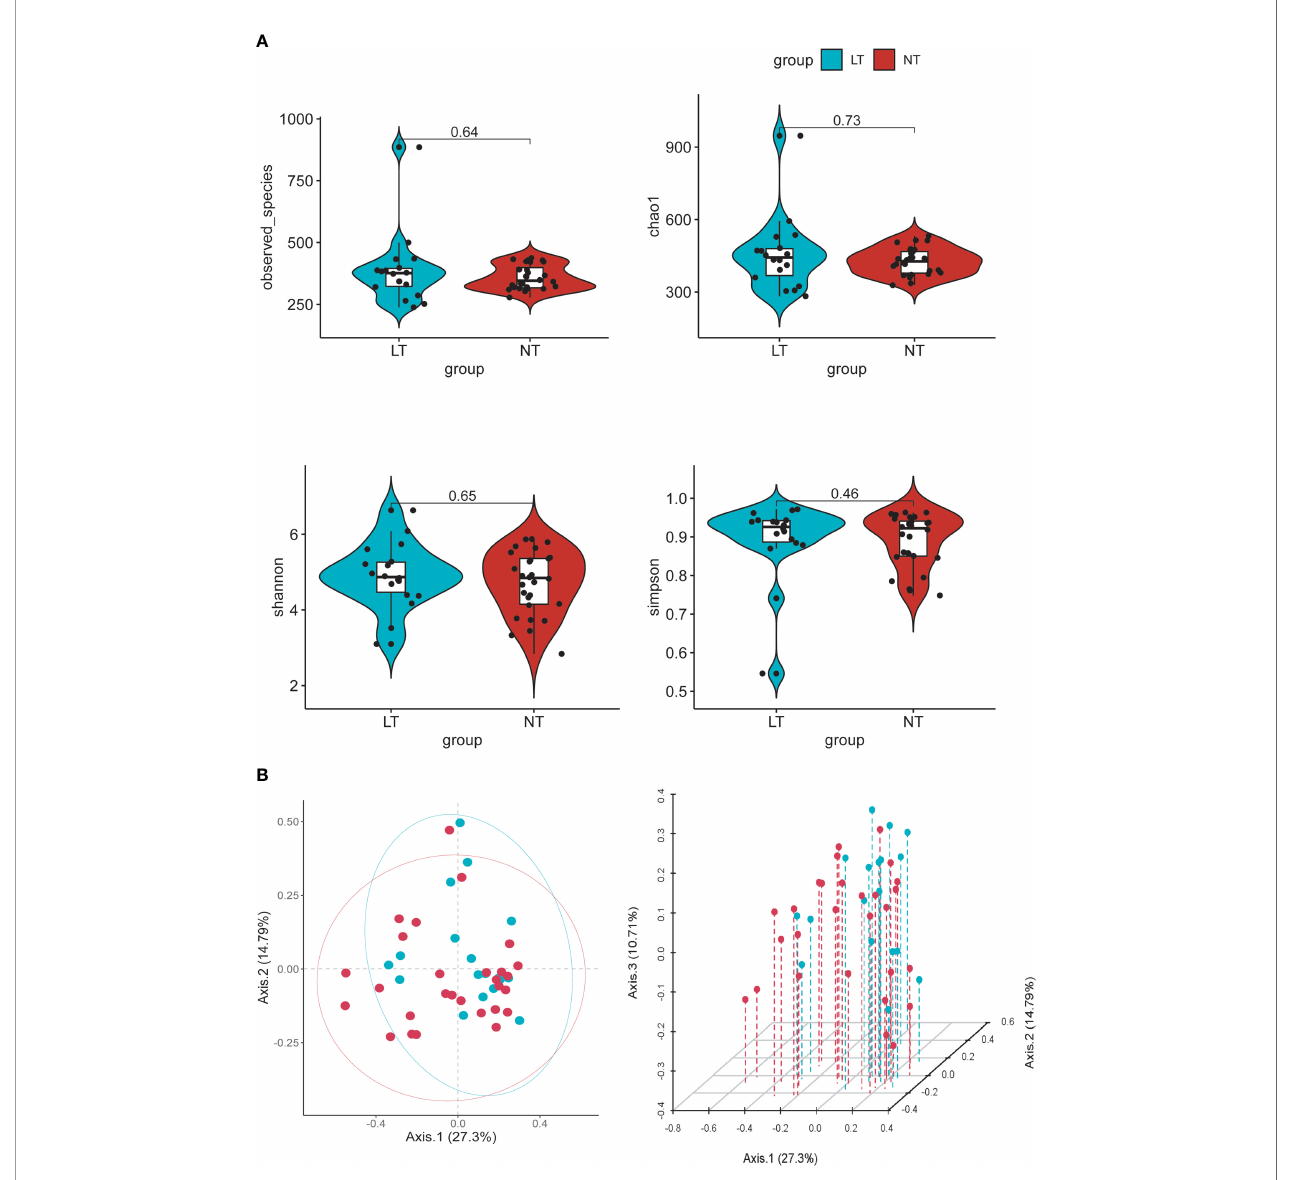
FIGURE 2 | Alpha and beta diversity of the gut microbial communities from participants. (A) Comparison of observed OUT Numbers, chao1, shannon and simpson indexes between two groups. (B) Principal coordinate analysis (PCoA) of fecal microbiota, each dot represents the bacterial community composition of one individual stool sample, and the axis titles indicates the percentage variation explained (27.3% and 14.79 %,